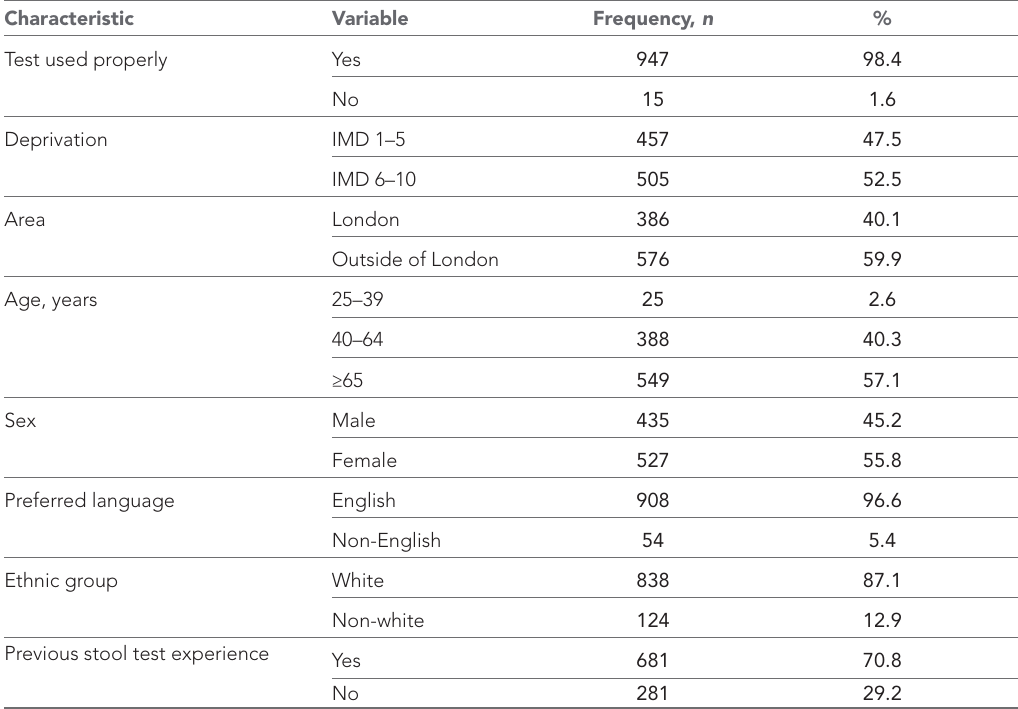
Table 6 Numbers of patients within variable groups used in logistic regression a